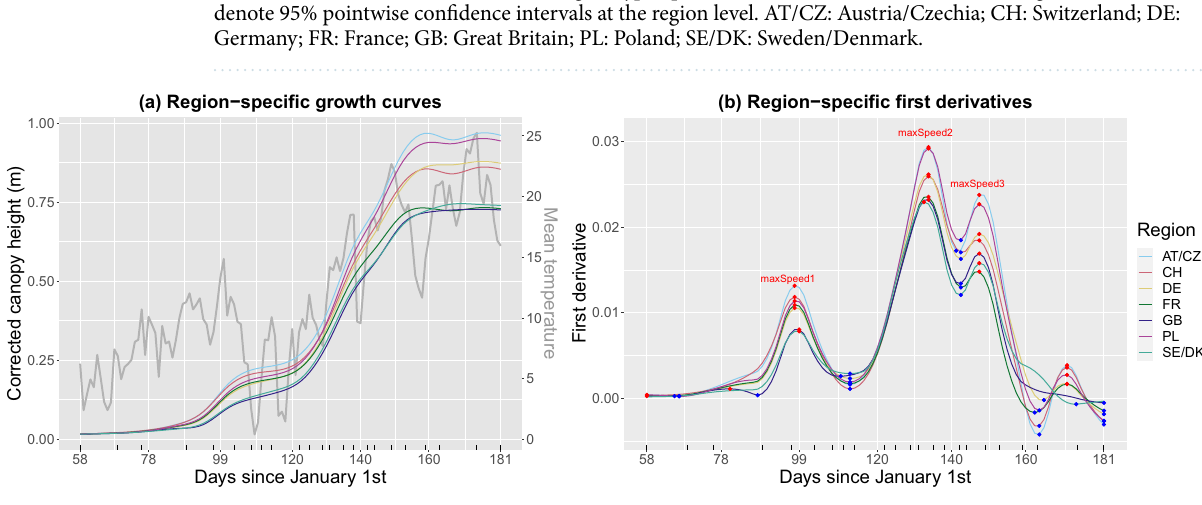
Figure 7. Results of the second stage for the ETH field phenotyping platform: ( a ) region-specific growth curves (coloured lines) vs. mean temperature (grey line), and ( b ) region-specific first-order derivatives; blue and red points indicate (local) minima and maxima, respectively. AT/CZ: Austria/Czechia; CH: Switzerland; DE: Germany; FR: France; GB: Great Britain; PL: Poland; SE/DK: tives (Figs. 6b and 7b). These speed rates correspond to maxima around DOYs 97, 133 and 147, respectively. Maximum speed rates around DOY 133 (maxSpeed2) and 189 (maxSpeed3) can be interpreted, respectively, as recoveries after a severe cold period in April (DOY 110-120) and a milder one in May (DOY 140) (Fig. 7a, grey line). However, it appears that already for maxSpeed3 the growth rates declined as plants approached their final height. We also estimated the area under the genotype-specific deviations (Fig. 6c) as a global measure of a genotype performance over time when compared to the genotypes of the same region. A positive (negative) area indicates a genotype performance better (worse) than the regional average. Here, the area (AUC) was estimated